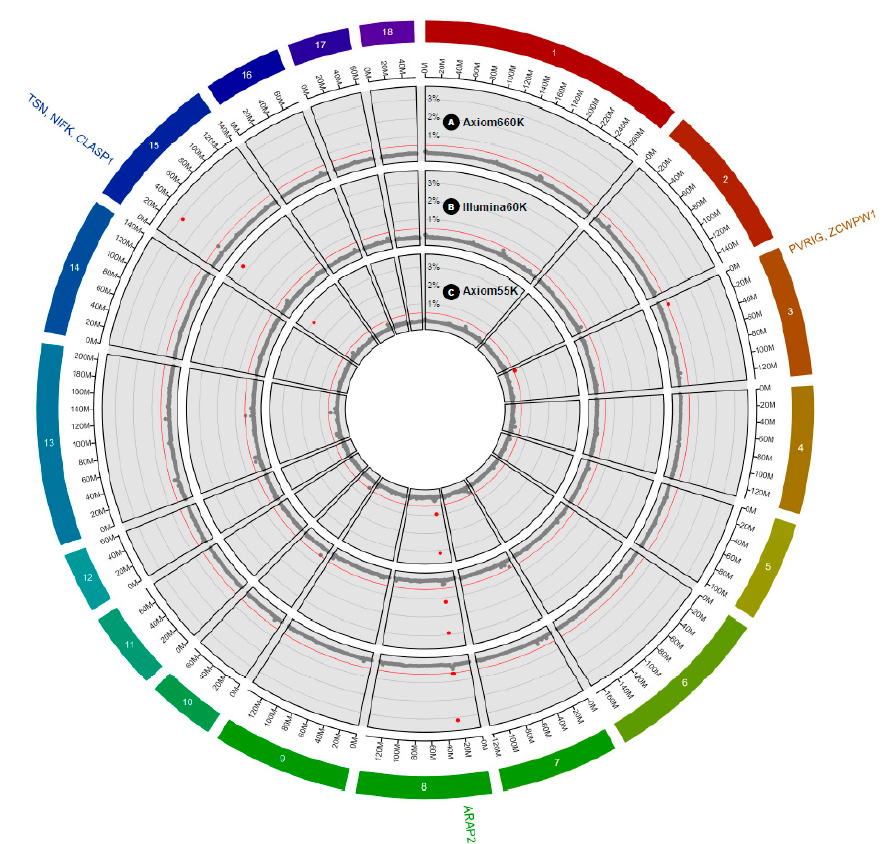
Figure 1. A circular Manhattan plot of the window variances of the individual birth weight trait using the three genotyping platforms, where the (A) outer, (B) middle, and (C) inner radii reflect Axiom650K, Illumina60K, and Axiom55K, respectively. The red horizontal lines and the red dots represent 0.5% of the window variance and the windows above the 0.5% threshold, respectively. Genes corresponding to the common significant windows across the genotyping platforms have been indicated outside of the plot. The gene annotations include ArfGAP with RhoGAP domain ankyrin repeat and PH domain 2 (ARAP2), Translin (TSN), nucleolar protein interacting with the FHA domain of MKI67 (NIFK), PVR-related immunoglobulin domain containing (PVRIG), zinc finger CW-type and PWWP domain containing 1 (ZCWPW1), and the cytoplasmic linker-associated protein 1 (CLASP1).